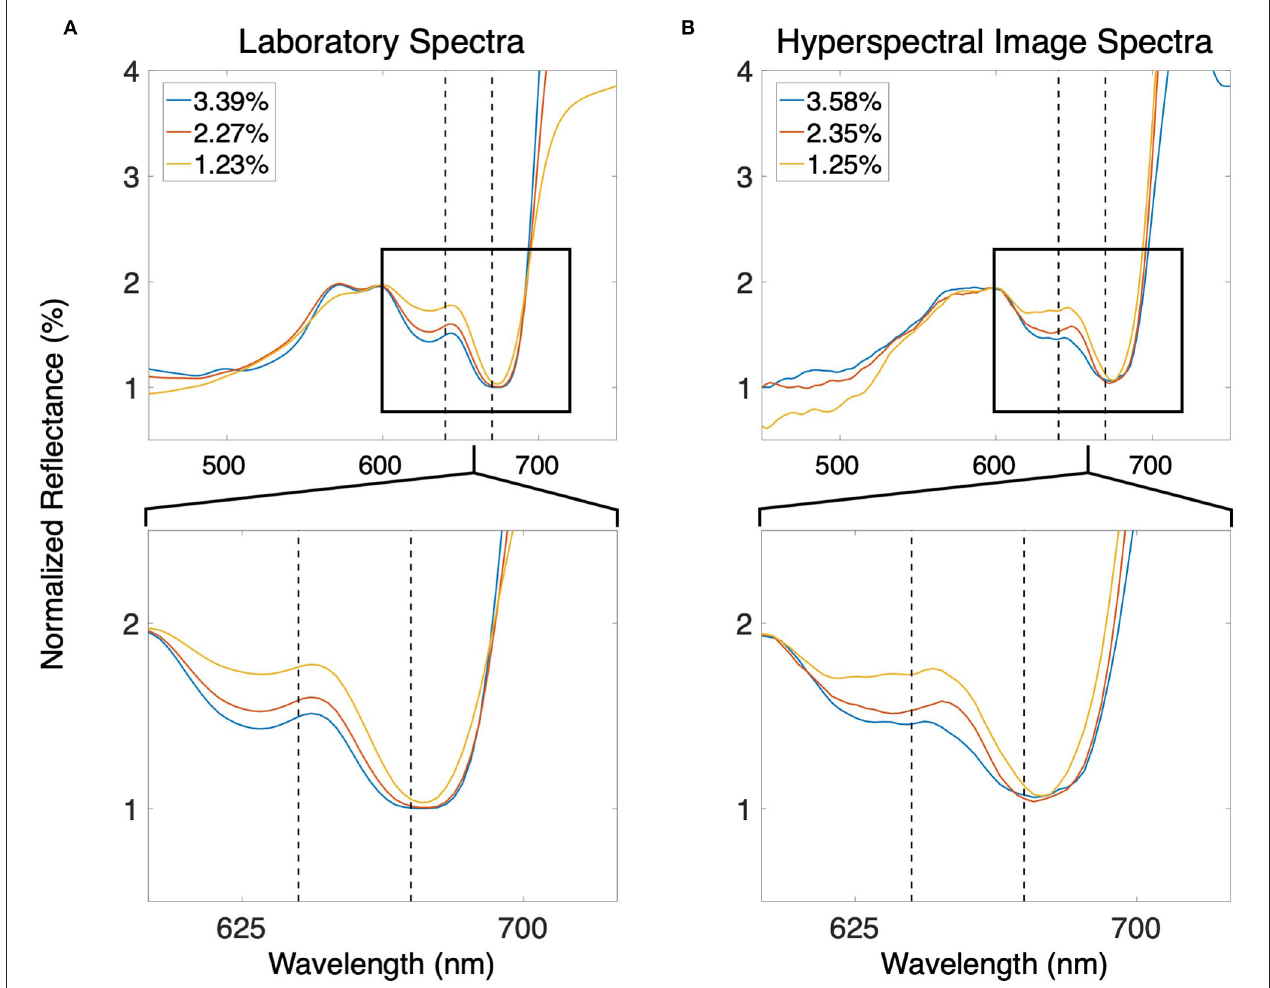
FIGURE 2 | (A) Smoothed normalized reflectance spectra of giant kelp canopy blades with different tissue nitrogen contents measured in the laboratory. (B) Smoothed normalized reflectance spectra of the giant kelp canopy using the sUAS hyperspectral sensor. Tissue nitrogen content estimated using the ratio of the spectral bands centered at 670 and 640nm (dashed black lines). The bottom panels show enlargements of the areas inside the black boxes in the top panels.